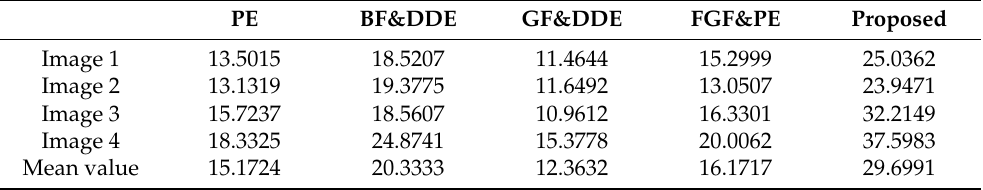
Table 4. The average gradient results among different methods.